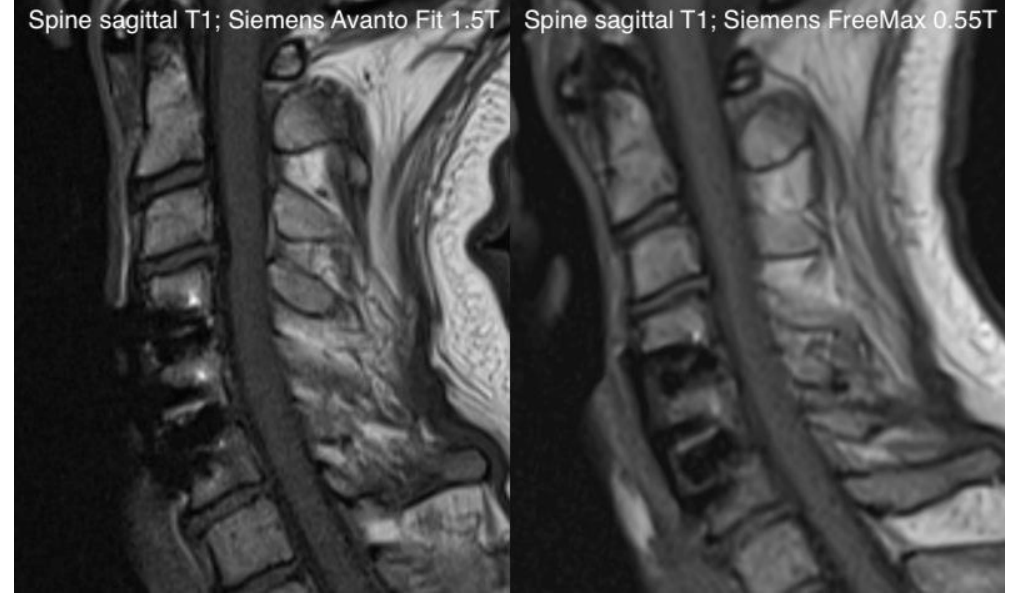
Figure 7. Exemplary comparison of a sagittal T1-sequence in the context of spine-imaging with the Siemens Avanto FIT 1.5T (left side) and the Siemens Free Max 0.55T (right side).